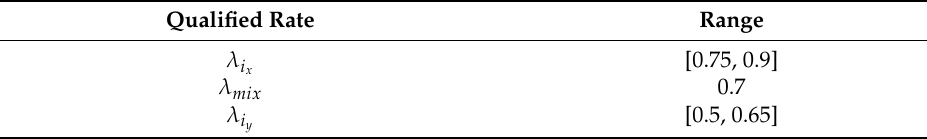
Table 1. The qualified rate of materials in manufacturing units.